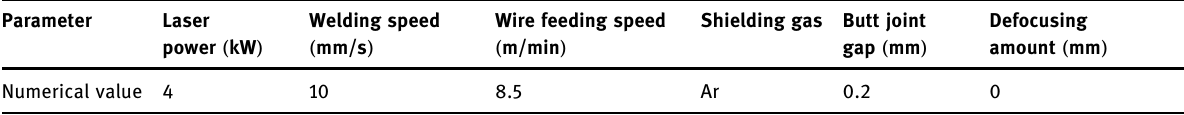
Table 2: Laser - arc composite welding process parameters